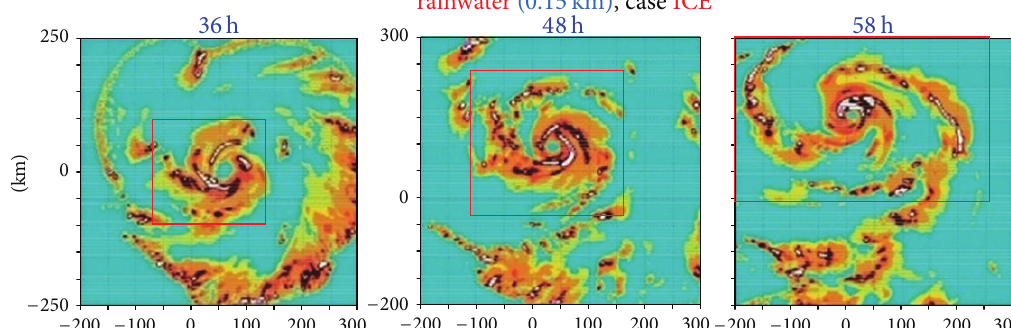
Figure 7: Rainwater mixing ratio at 0.15km at 36h, 48 h, and 58 h in case ICE. The red square indicates the area where the magnitudes of cloud physical processes (Figures 9, 10, and 11) are